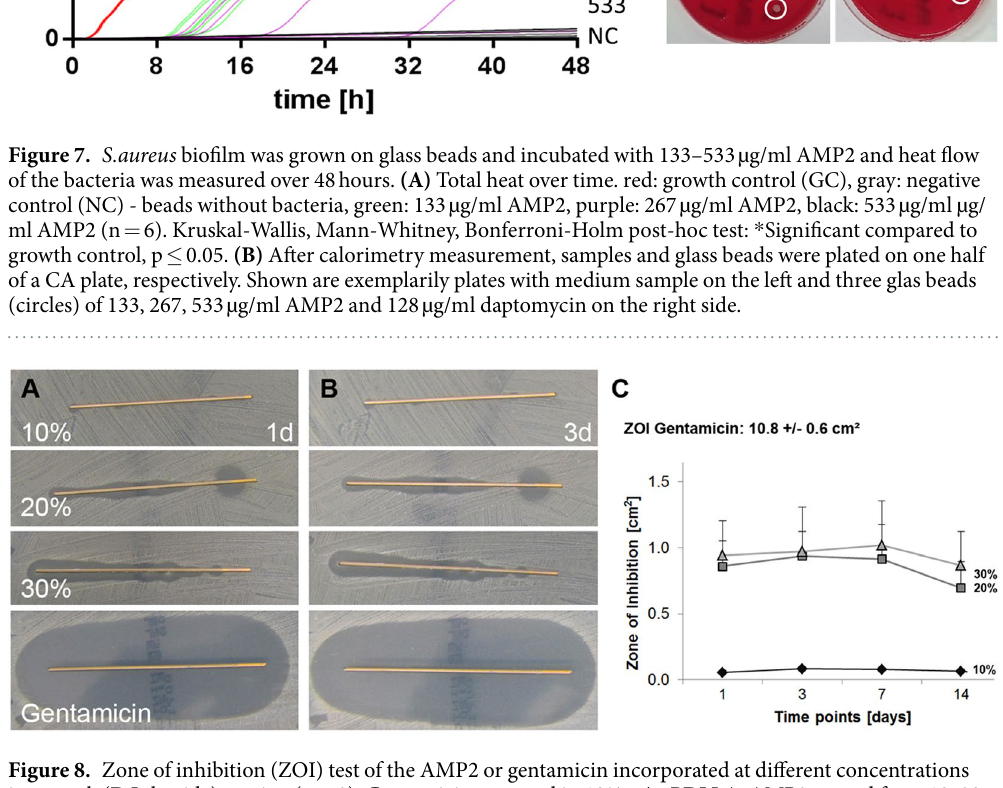
stable against proteases did not show these effects (unpublished results). MH broth is also not a well-defined media and could cause the bacteria to produce more or less proteases. In addition, the pre-cultivation, and the used cultivation method might have an influence. For the AMP2 used in the detailed analysis of the present study, the MIC difference for E . coli, P . aeruginosa, S . epidermidis was approximately two fold. Whereas it was much higher for S . aureus or E. feacalis , respectively. In a recent publication from Mikut at al. more than 3000 9mer pep- tides were investigated in order to find activity rules 24 . The data confirmed previous observation that simple phys- icochemical parameters are not good predictors, but the right balance between R, K and hydrophobic amino acids (I, V, F, Y, and W) 25 . There is also no positional preference for any amino acid. The current set of five peptides, however, is too small to correlate activity and sequence, especially given the photolytic effects described before. Another substance that might have an influence on the antimicrobial activity of AMPs is serum and/or com- ponents of the serum. Svenson et al . demonstrated that the presence of albumin induced a 10-fold increase of the minimal inhibitory concentration of lactoferricin-derivates for Staphylococcus aureus 13 . It is assumed that this decrease in activity is due to the 1:1 binding of the peptide and albumin. In a further study the effect of serum on hexcameric AMPs was investigated 26 . Depending on the modification of the peptide the antimicrobial activity or the protease resistance was increased. Testing the antimicrobial activity after addition of serum, however, showed a negative effect on the activity independent of the modification. Therefore, not only the degradation in the serum might impact the activity, but also the increased ionic-concentration and also binding with serum components might be responsible. In the present study serum decreased dosage dependent the activity of the AMP and this shows the importance of testing more physiological conditions than rather optimized culture conditions. Serum